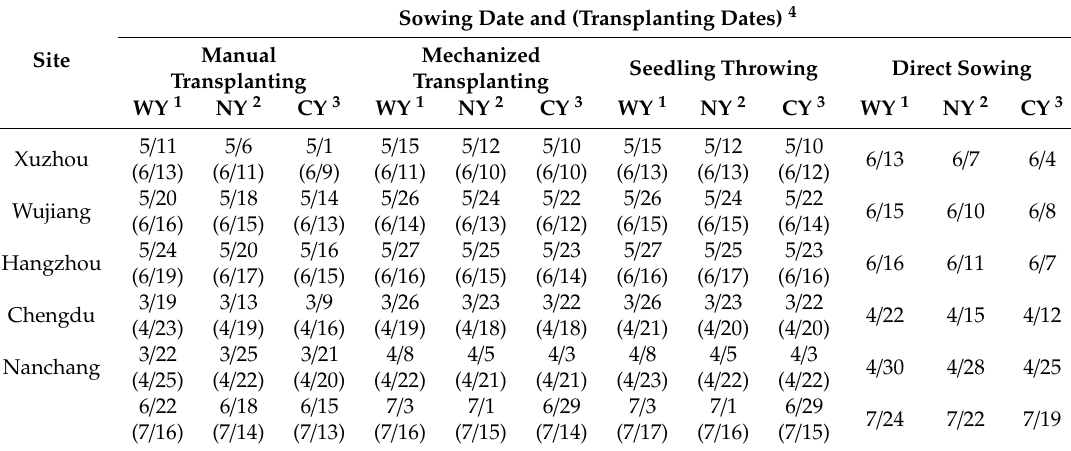
Table 6. Simulation of sowing and transplanting dates under di ff erent